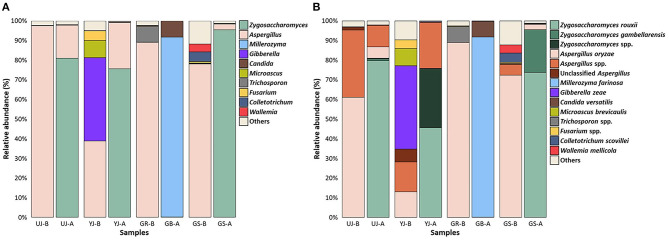
Fungal composition in the gochujang samples before and after fermentation. Data portray (A) genus and (B) species level of internal transcribed spacer sequences. The “others” are composed of the genera or species with a prevalence of <0.5% of the total reads in each sample.